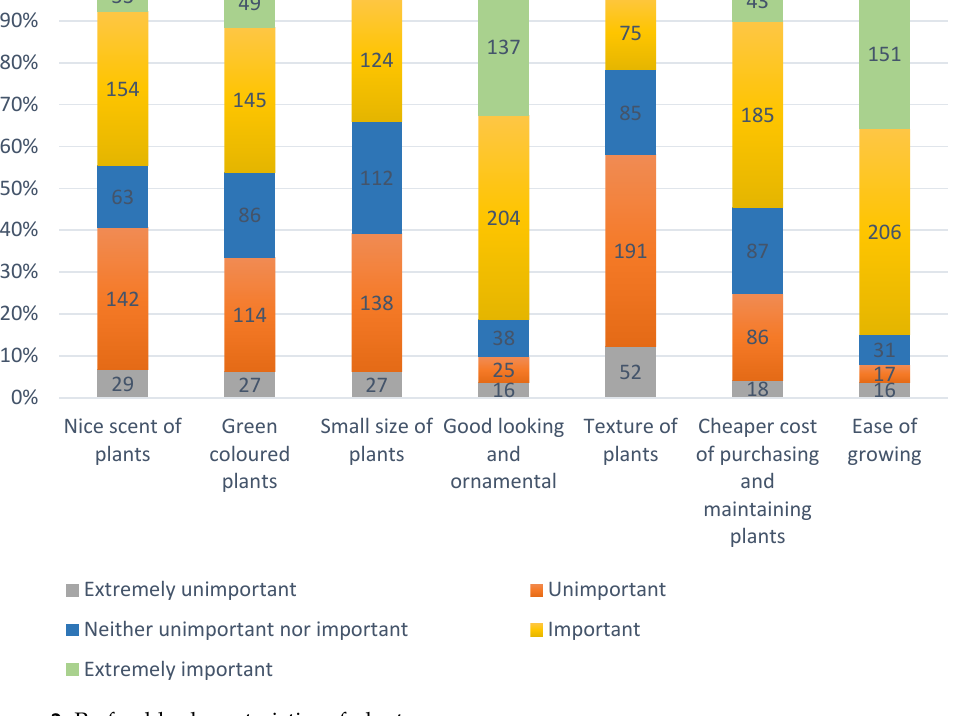
Figure 2. Preferable characteristics of plants.